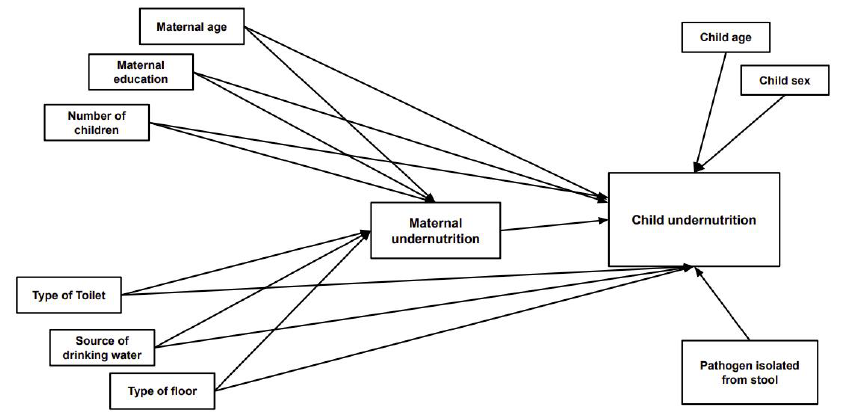
Figure 1. Factors associated with maternal and child undernutrition.